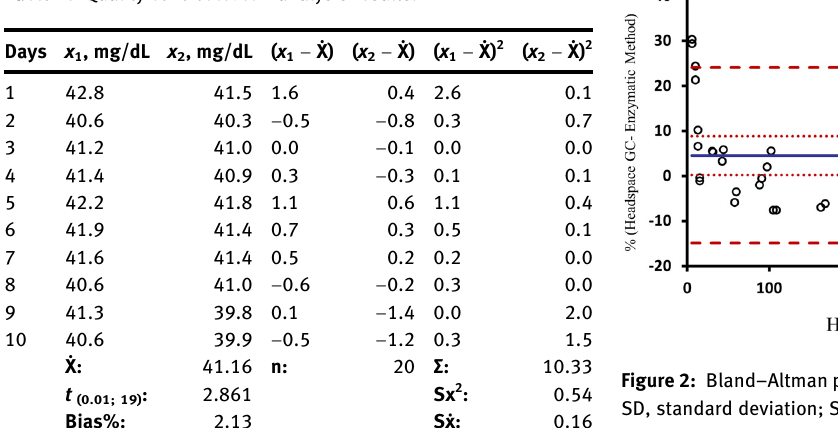
Table  : Quality control level  analysis results.